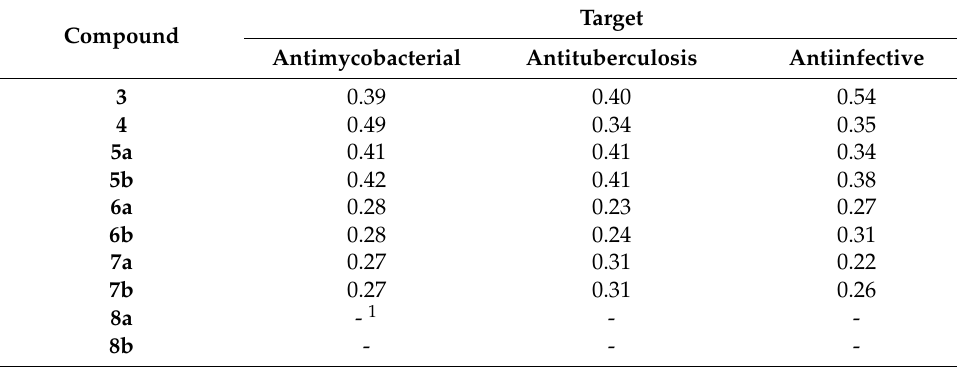
Table 6. The probability of compounds 3 , 4 , 5a , b , 6a , b , 7a , b , and 8a , b to be active (Pa) as antimicro- bials as predicted by PASS analysis.